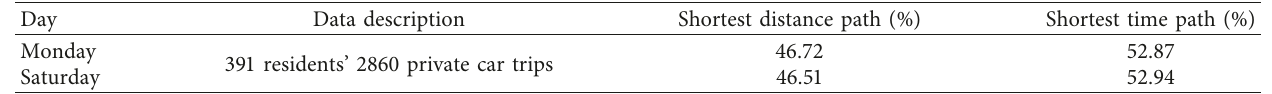
Figure 7: Path comparison. (a) Shortest distance path of Baidu; (b) the actual Table 4: The proportion of residents choosing the shortest path in Chongqing.